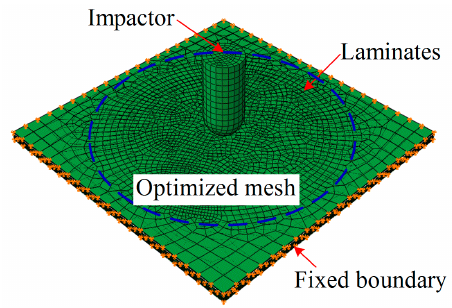
Figure 2. Modeling the impact test of the composite laminate.